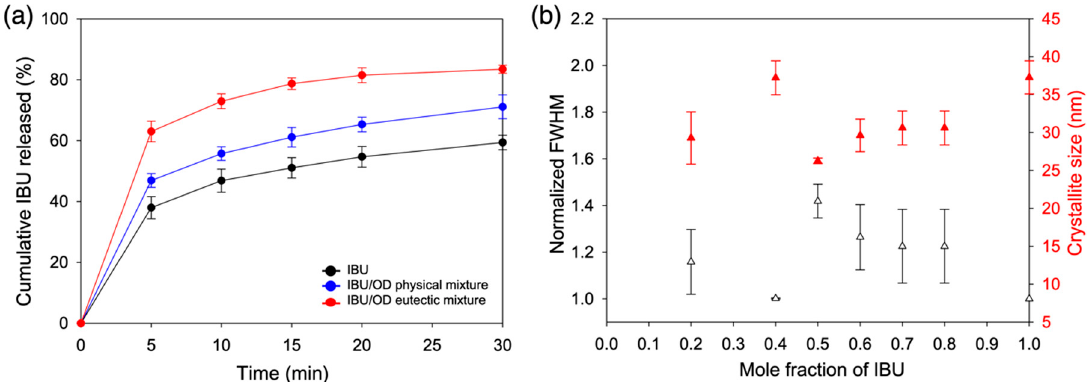
Figure 4. ( a ) Dissolution profiles (FeSSIF, n = 3) of the IBU/OD eutectic mixture (5:5) in comparison of physical mixture and neat IBU. ( b ) Microstructure analysis using peak broadening of X-ray diffraction peaks. Crystallite size was calculated using (2 0 0), (2 1 0), and (2 1 − 1) diffraction peaks with the use of Scherrer equation, and the full width at half maximum (FWHM) was shown as normalized against the narrowest peaks (neat IBU).